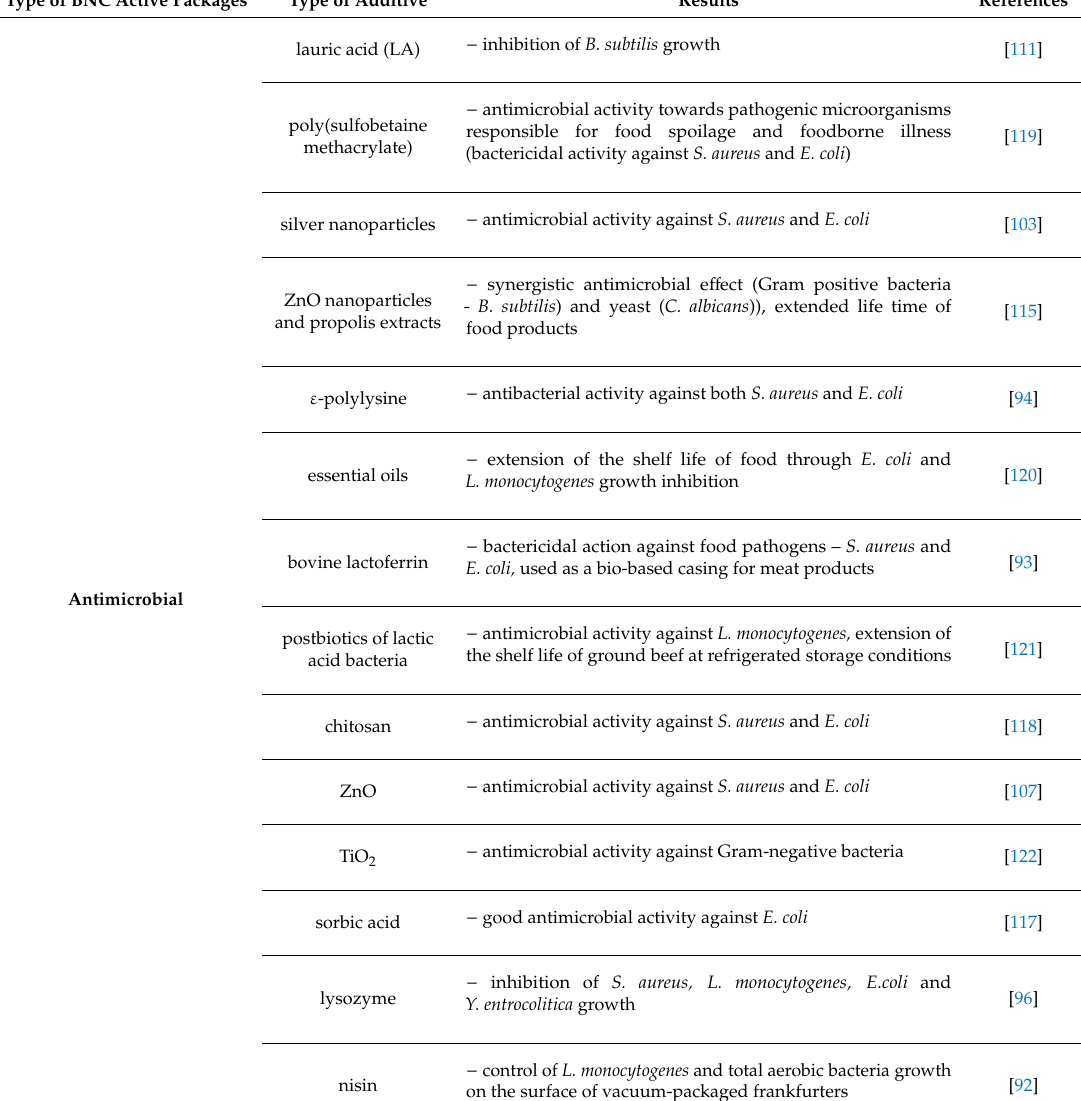
Table 1. The overview of BNC-based active packages and their e ff ect on foodstu ff